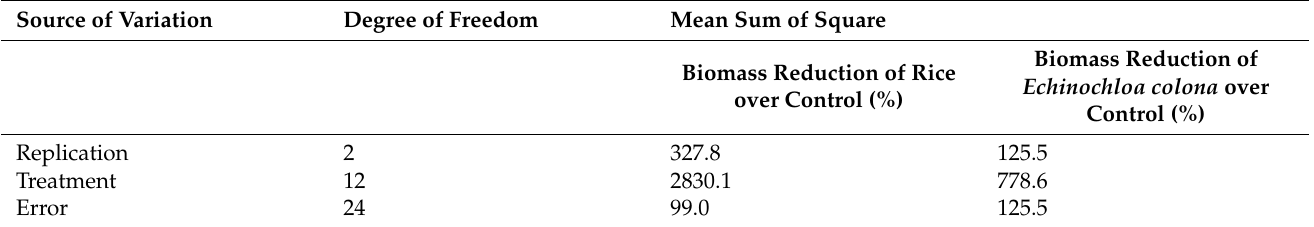
Table A2. Analysis of variance for different parameters in Experiment 1.